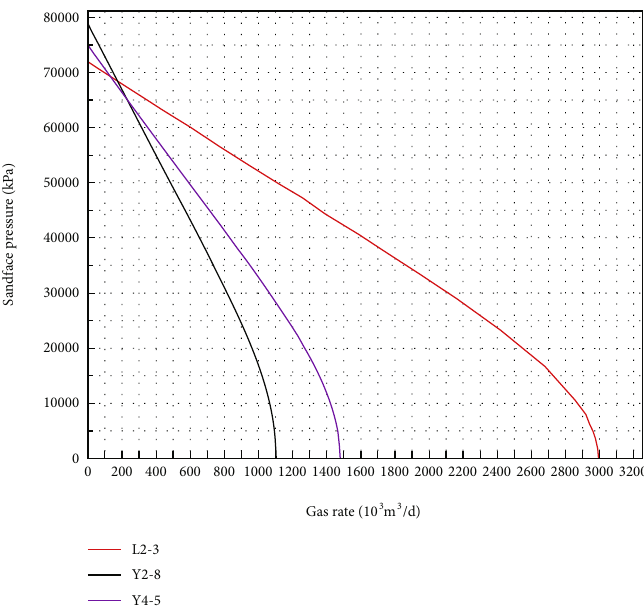
Figure 6: Numerical simulation results of IPRs of shale gas wells.